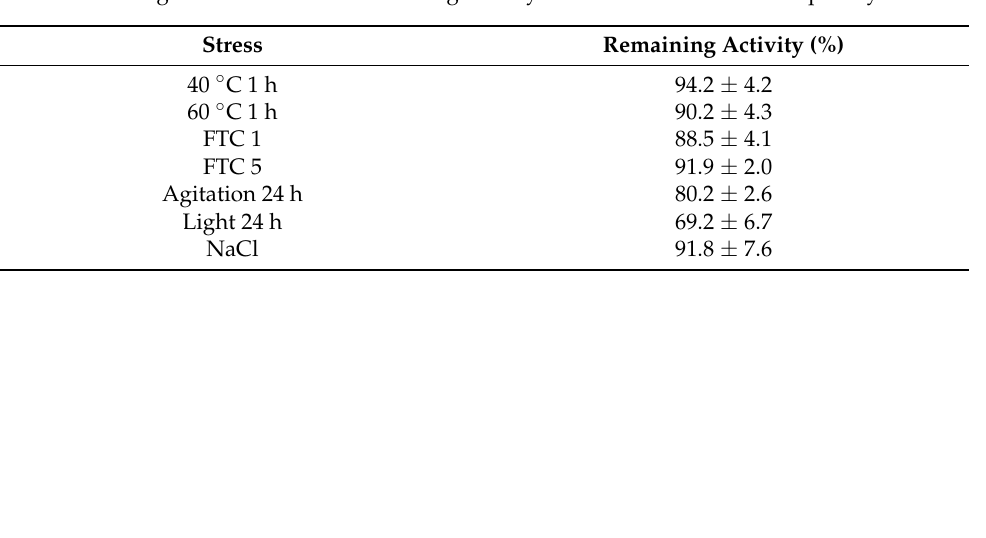
Table 9. Percentage estimation of the remaining activity in stressed nivolumab samples by